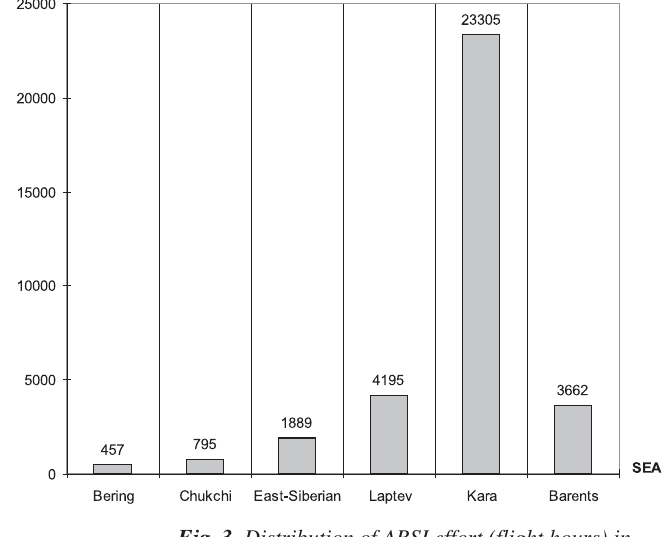
Fig. 3. Distribution of ARSI effort (flight hours) in different seas,